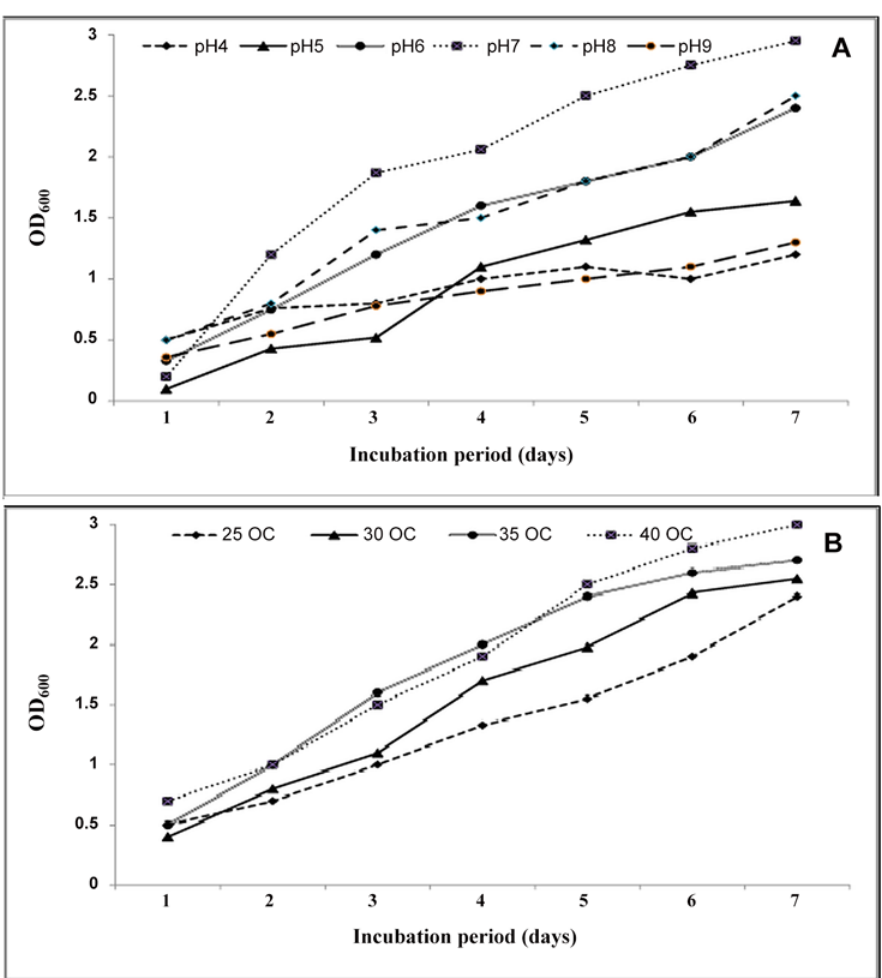
Fig 2. Effect of different pHs (A) and temperatures (B) on the optical density of strian 139SI.